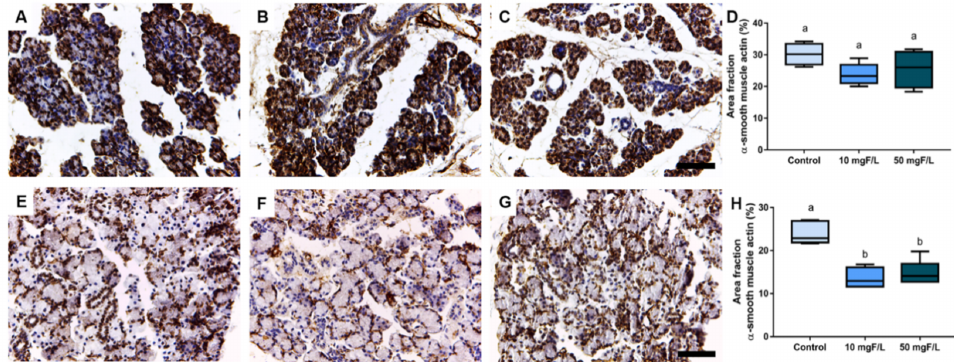
Figure 5. Immunohistochemical analysis of anti- α -smooth muscle actin of the tissues that comprise the parotid and submandibular glands of the offspring indirectly exposed to water containing 0 (control), 10 or 50 mg F/L for 42 days ( n = 5 animals/group). ( A – C ) represent the parotid glands of the control, 10 mg F/L group, and 50 mg F/L groups, respectively; in ( D ), the area fraction of the parotid gland; in ( E ), submandibular of the control group; in ( F ), submandibular in the 10 mg F/L group; in ( G ), submandibular in the 50 mg F/L group; in ( H ), the area fraction of the submandibular gland. Quantitative results are expressed as mean ± standard error, one-way ANOVA with Tukey’s post-test. Different letters mean statistical difference ( p < 0.05). Scale bars: 10 µ